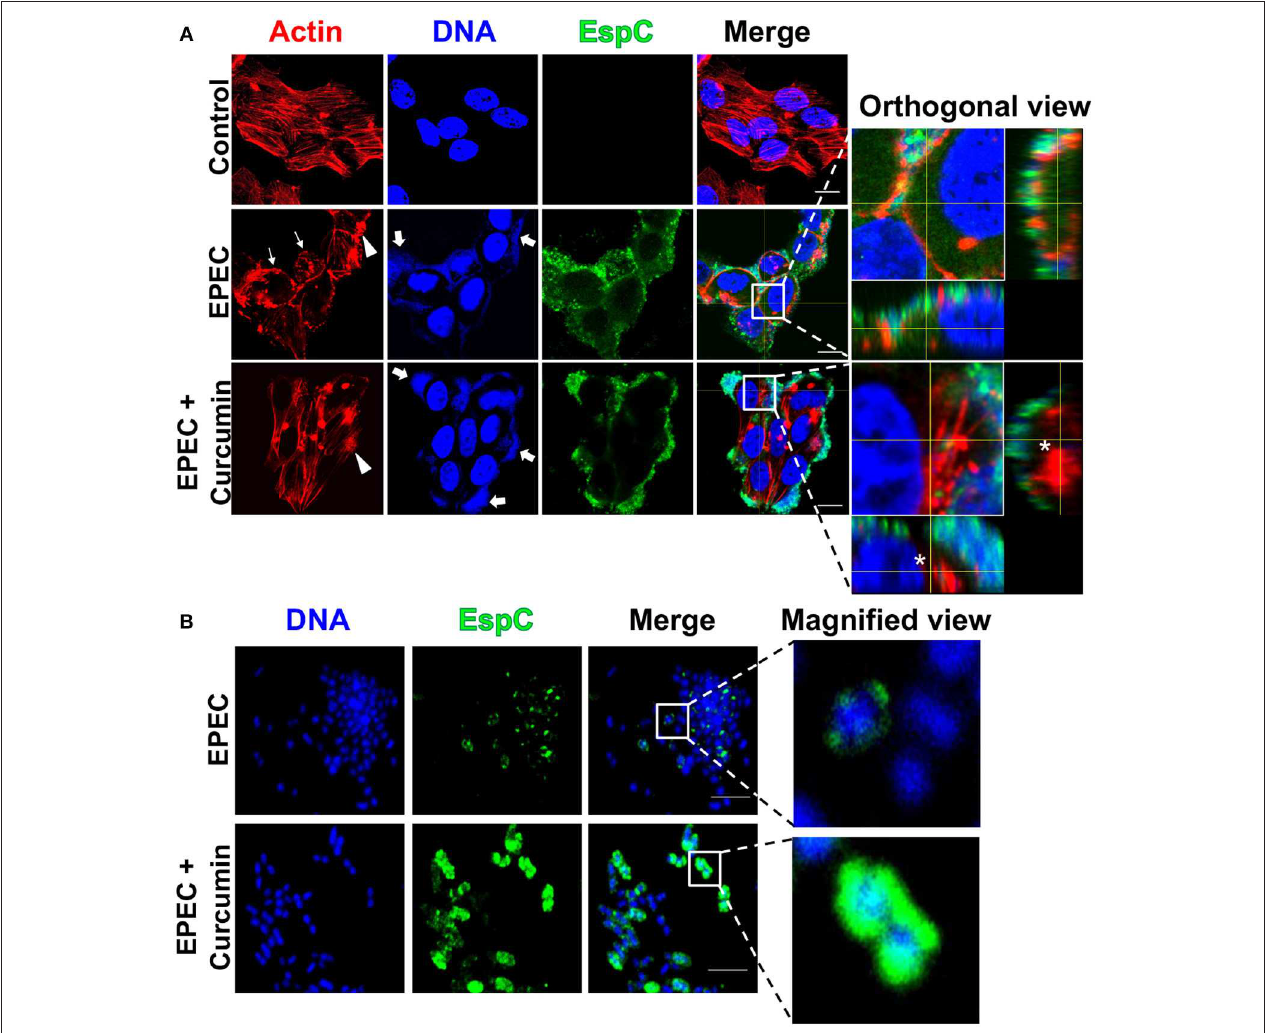
FIGURE 6 | Curcumin blocks the cytotoxic effect induced by EPEC in HEp-2 cells by inhibiting EspC internalization without affecting the formation of pedestals and its adherence pattern on epithelial cells. Confocal microscopy of HEp-2 cells infected with EPEC (MOI 10) during 2h (A) and a magnified view of bacteria-only (B) in presence or absence of Curcumin (16 µ g/mL). Uninfected cells were used as control. After treatment, cells were processed for confocal microscopy as indicated in Figure 5 , but EspC secretion and internalization was detected by immunofluorescence using an anti-EspC passenger domain antibody followed by biotin-SP-conjugated goat anti-rabbit IgG and DTAF-conjugated streptavidin. Arrow indicates the localized adherence of EPEC on HEp-2 cells. Arrowheads indicates the formation of actin pedestals, while thin arrows indicate the cell rounding effect. An asterisk denotes the absence of internalized EspC in HEp-2 cells; scale bar 15 µ m in (A) . Scale bar 5 µ m in (B)